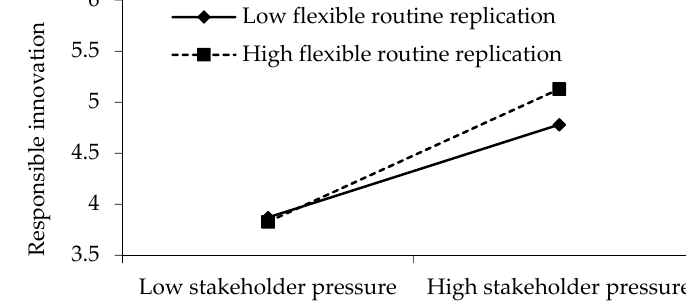
Figure 2. Diagram of regulating role. Table 6. Results of the mediated moderation